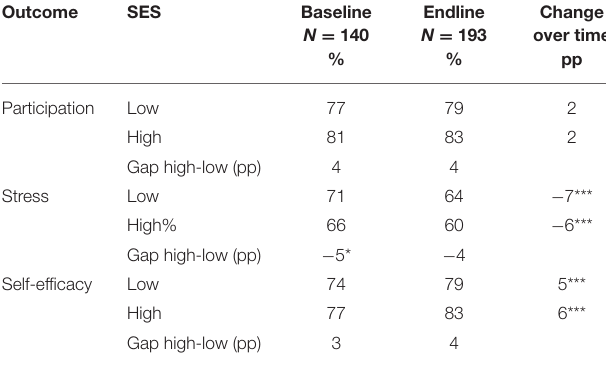
TABLE 5 | Comparison of baseline and endline changes in MHH literacy.